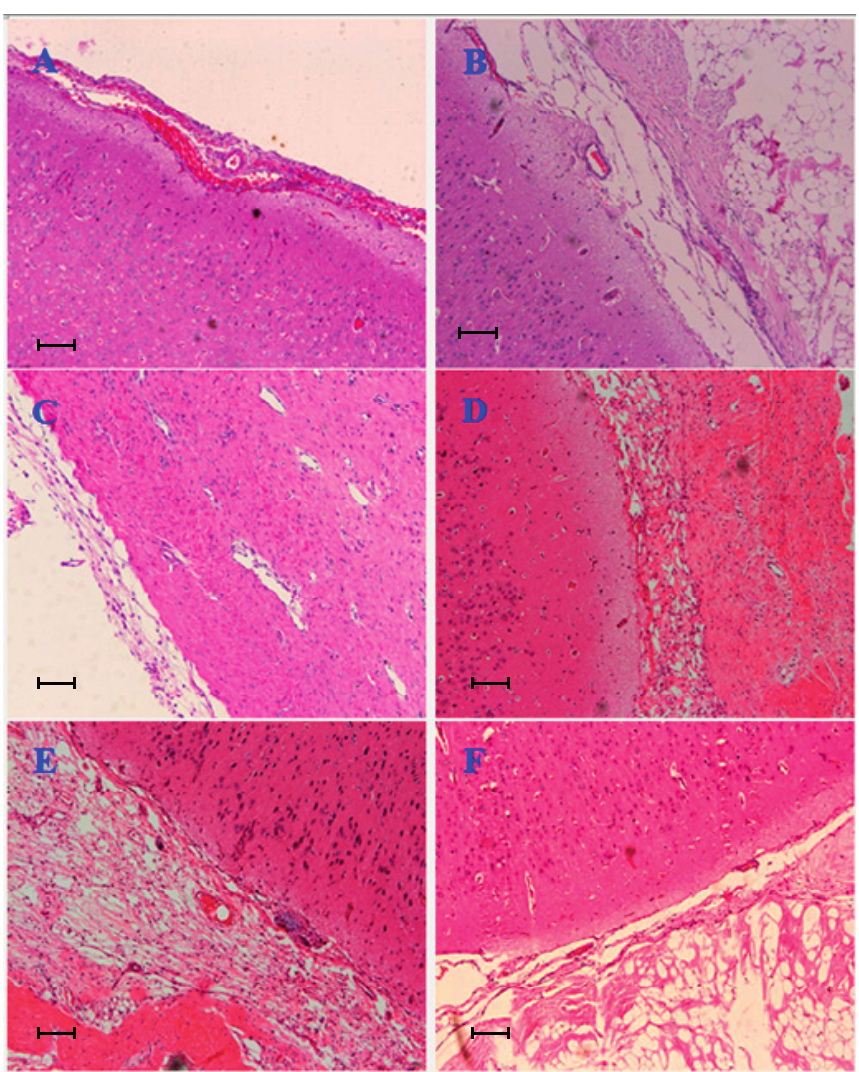
Figure 3. Histopathological observation of unrepaired side at each time point. (HE, ×100). ( A ) Day 7, inflammatory cells were elevated compared to BC. Red blood cells had mixed in the meantime; ( B ) Day 14, fibroblasts appeared between subcutaneous tissue and brain tissue on the right side. Loose filamentous adhesions had formed; ( C ) Day 30, further increase in filamentous adhesions on the right side; ( D , E ) Days 90 and 180, the structure of adhesions on the unrepaired side became much more disordered; and ( F ) Day 360, adhesions existed on the unrepaired side as before. Scale bars = 50 µm in ( A – F